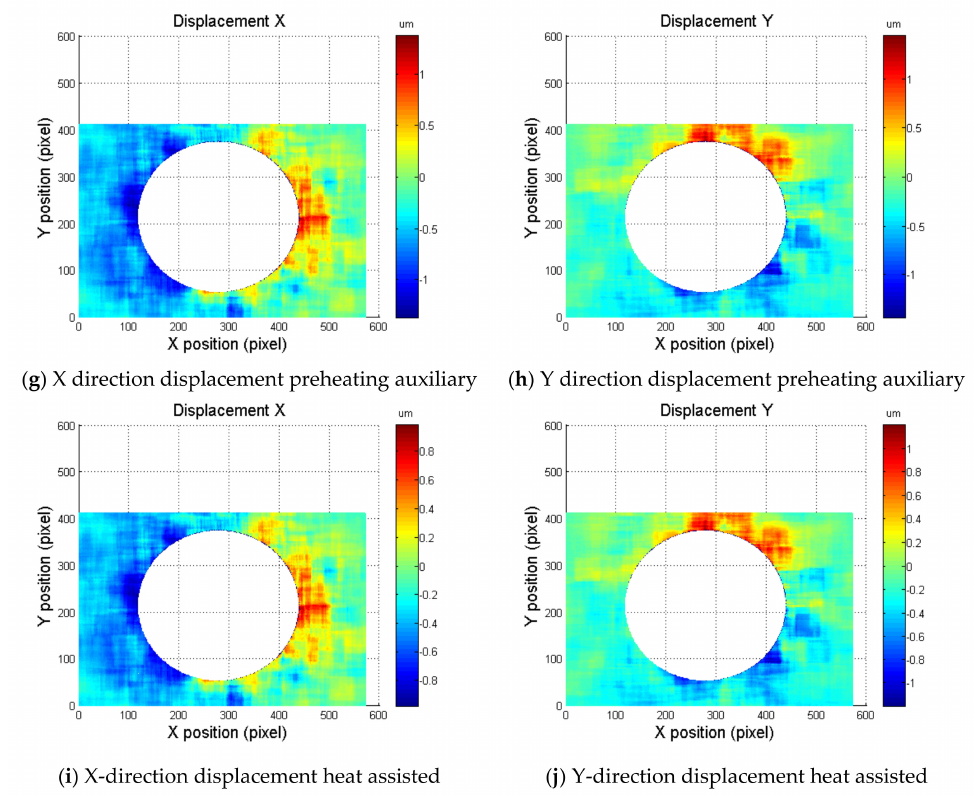
Figure 8. The measured surface deformation under different assist